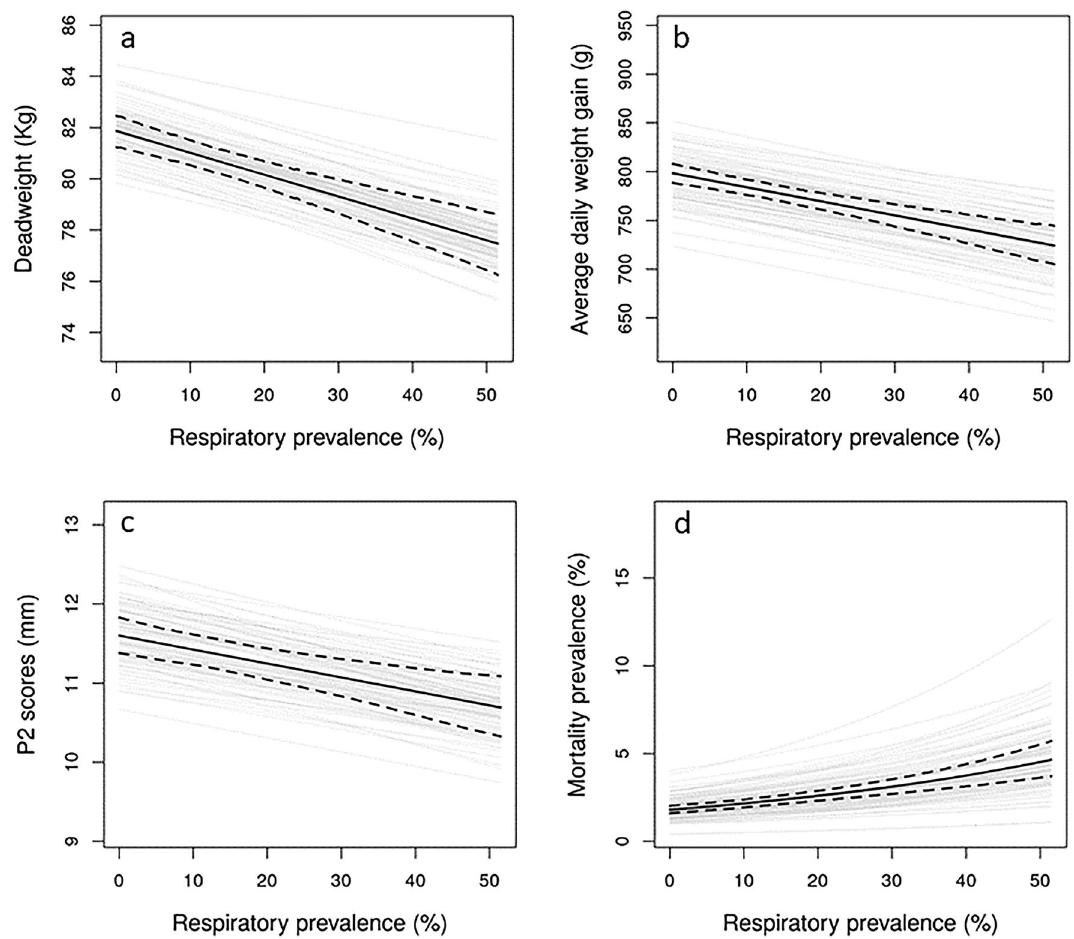
Figure 5. The effect of respiratory prevalence on ( a ) deadweight; ( b ) average daily weight gain; ( c ) P2 and ( d ) mortality. The posterior mean is denoted by the solid black line with the 95% highest density interval of the mean shown by the dashed lines. The grey lines show 100 representative samples from the posterior distribution marginalising across farm random effects. Respiratory prevalence was calculated from the counts of respiratory conditions and the total pigs in the